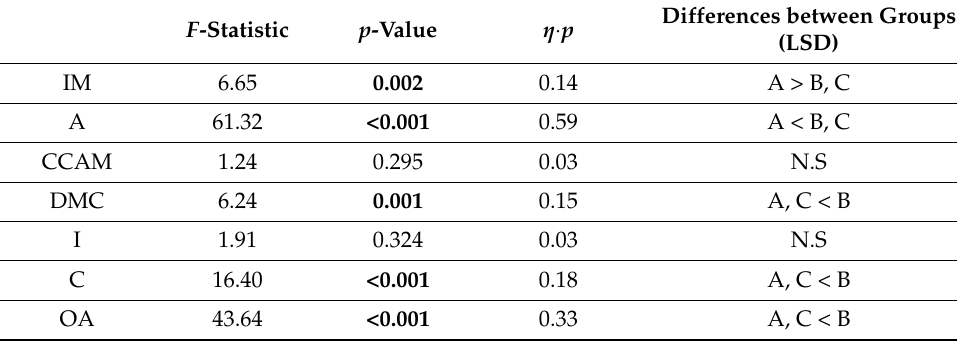
Table 3. Differences between the three clusters on the